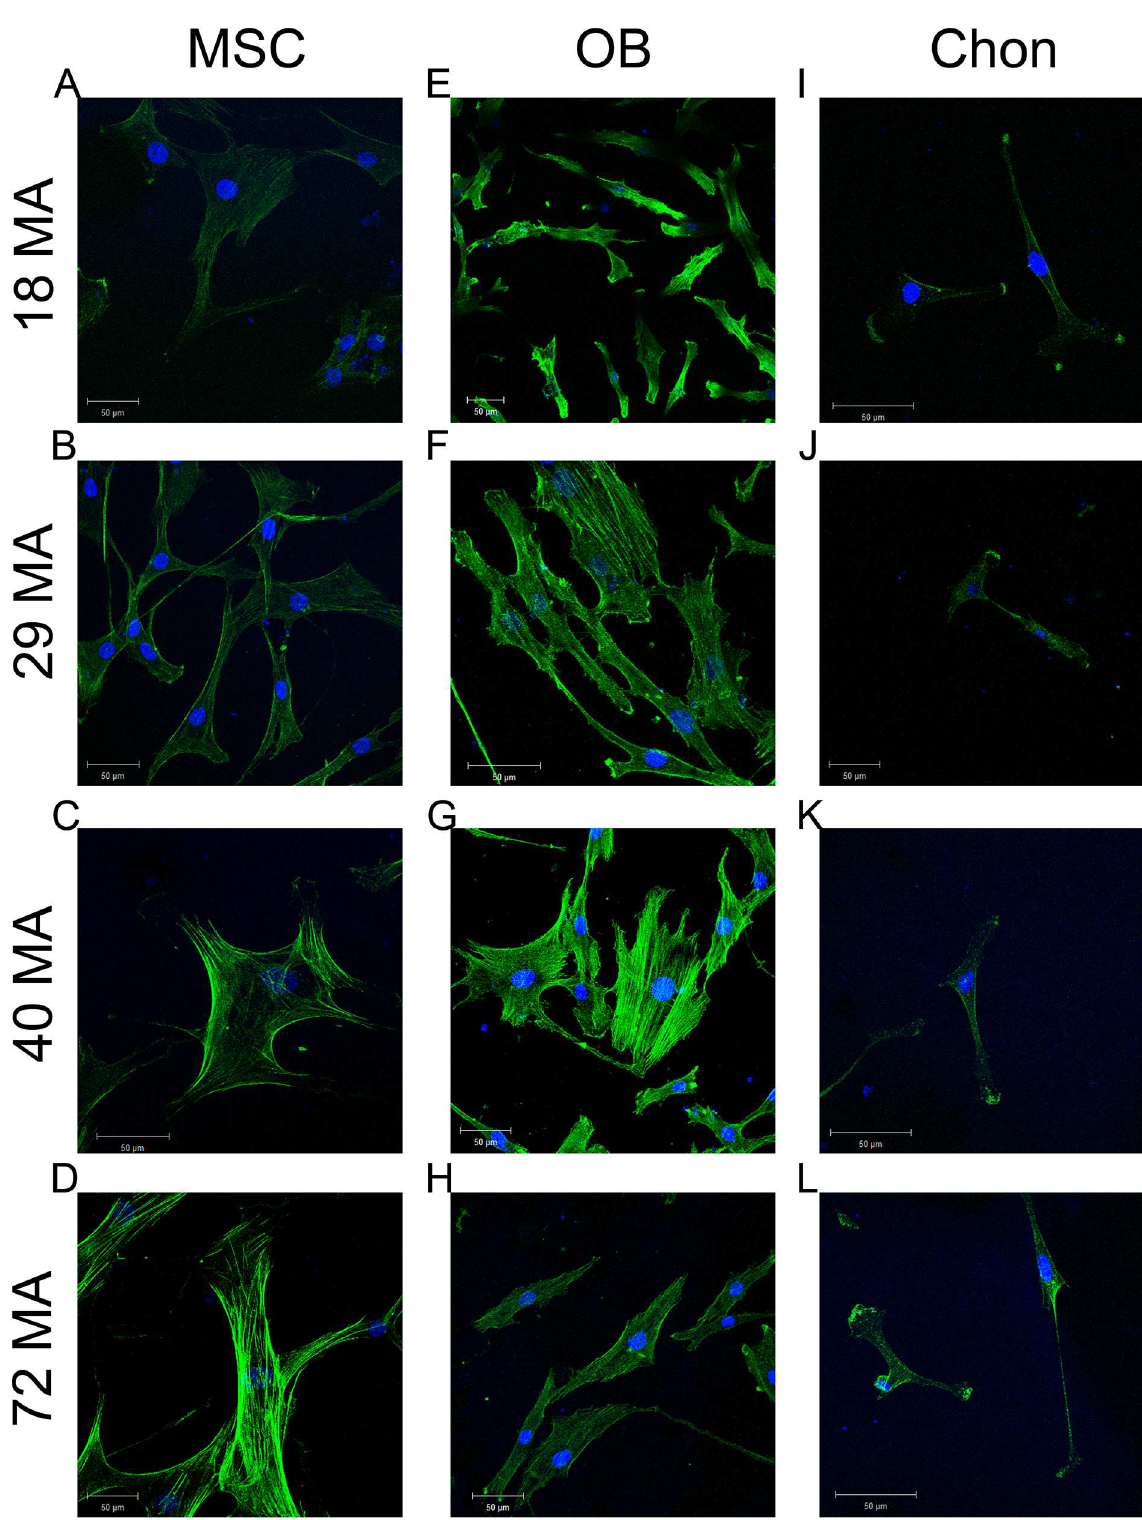
Fig 3. Cytoskeleton arrangement was altered by substrate stiffness. Representative staining of F-actin by phalloidin(green) and nuclei by DAPI (blue) in humanMSCs (A-D), HOBs (E-H), and chondrocytes (I-L) culturedon surfaces of varying stiffness. (Scale bars: 100 μ m for A,B,D; 50 μ m for all others.)